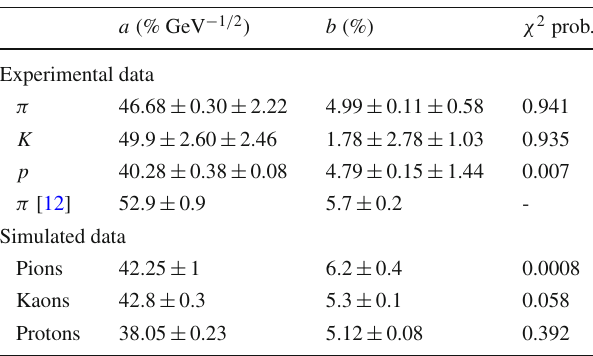
Table 13 Values of the parameters a and b obtained fitting Eq. (30) to the experimental and simulated fractional resolution values R σ raw obtained using pions ( π ), kaons ( K ) and protons ( p ) as a function of √ E beam [ GeV ] (Fig. 21). In the case of experimental data results, sta- 1 / tistical and systematic uncertainties are reported. Only statistical uncer- tainties are shown for simulated data. The χ 2 probability values of the fits are reported. Previous pion results are also shown ( π [12]) a (% GeV − 1 / 2 ) χ 2